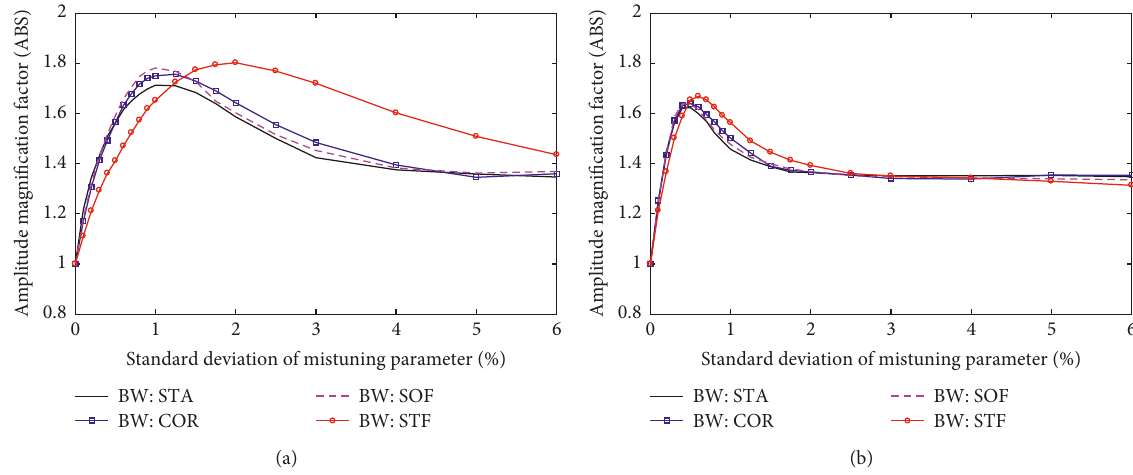
Figure 18: 95 th percentile of absolute AMF versus standard deviation of mistuning parameter under the action of (a) 3EO and (b) 4EO backward traveling wave excitations. Monte Carlo simulation of 2000 mistuning patterns generated by uniform distribution of mean 0 is conducted for each point.